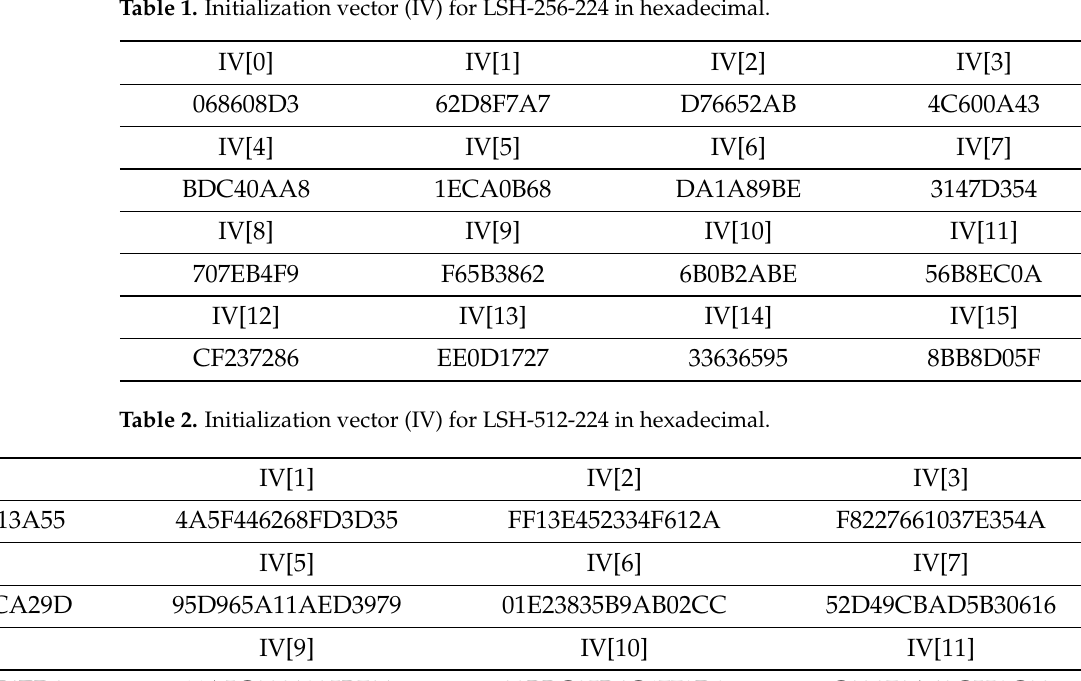
Table 1. Initialization vector (IV) for LSH-256-224 in hexadecimal.